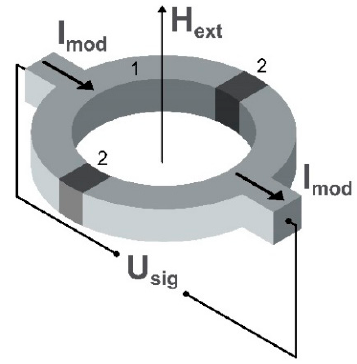
Figure 3. Schematic illustration of the sensing element of the dc SQUID (Super Quantum Interference Effect) magnetometer, where H ext is the applied external magnetic field. U sig is the voltage variation detected by the magnetic field-induced imbalance of the current I mod flowing through the two semiconducting loops (1) and the two Josephson junctions (2) of the sensing ring.